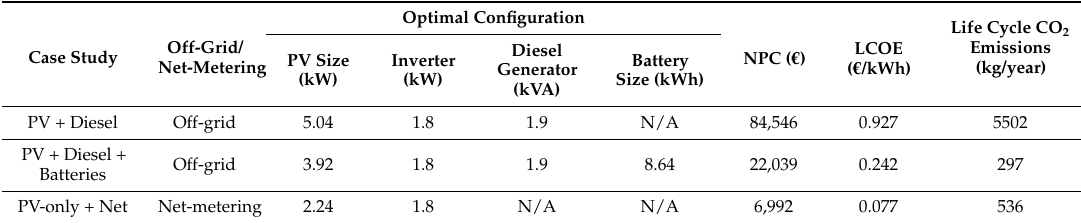
Table 6. Summary of the optimal project results obtained by